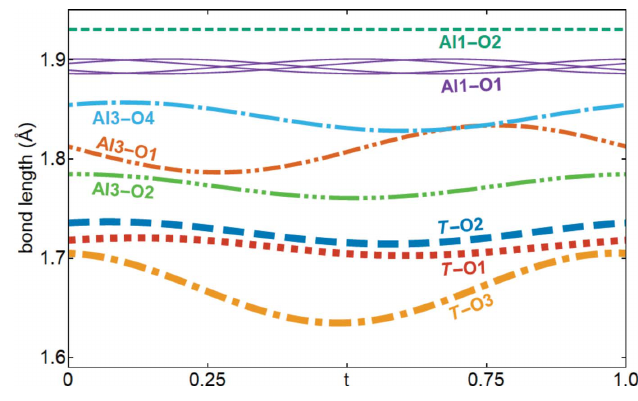
Figure 5 Modulated lengths of cation–oxygen bonds resulting from the displacive modulation.